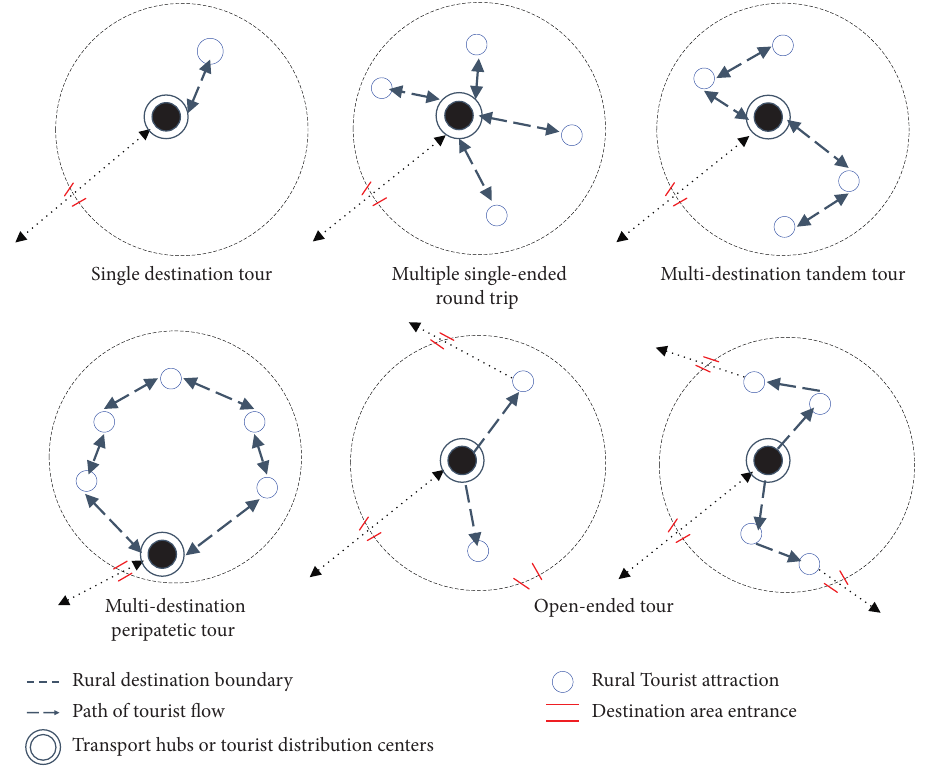
Figure 1: Typical mobility patterns of rural